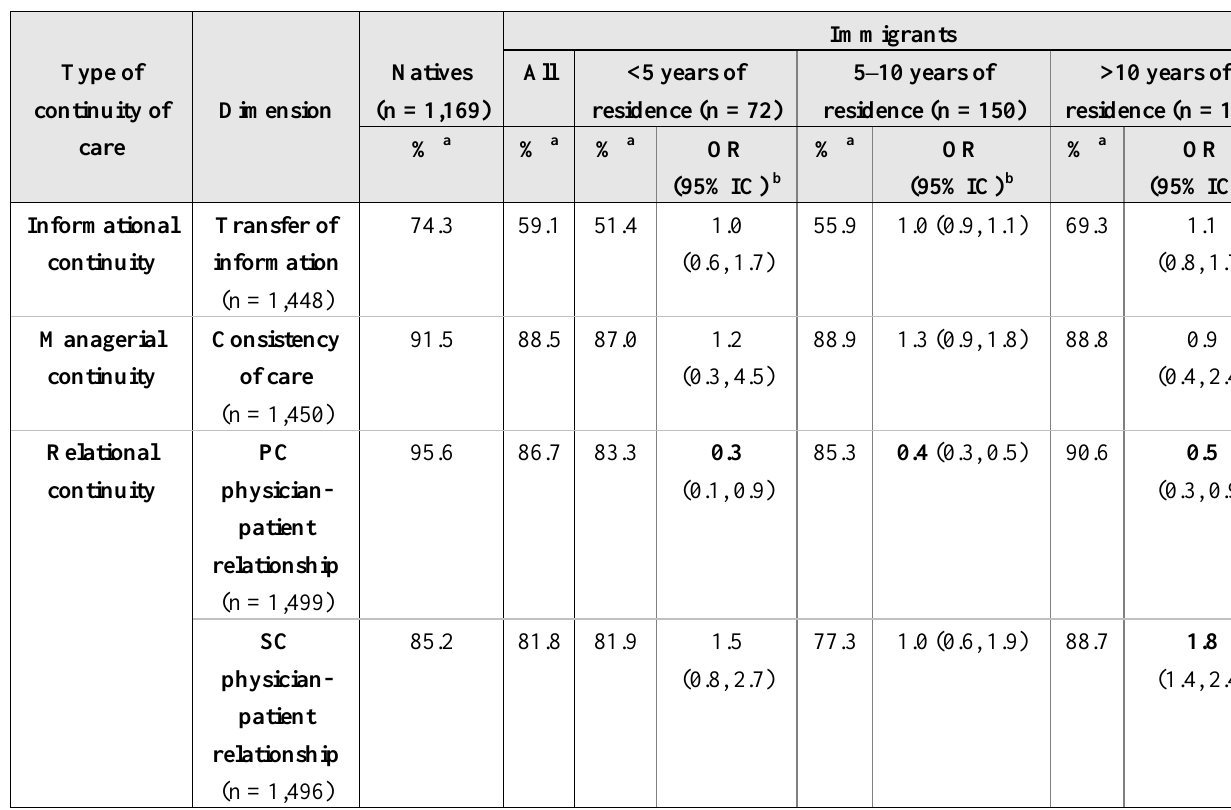
Table 2. Descriptive analysis and logistic regression models: adjusted relationships between continuity of care perceptions and immigration status according to the length of residence in